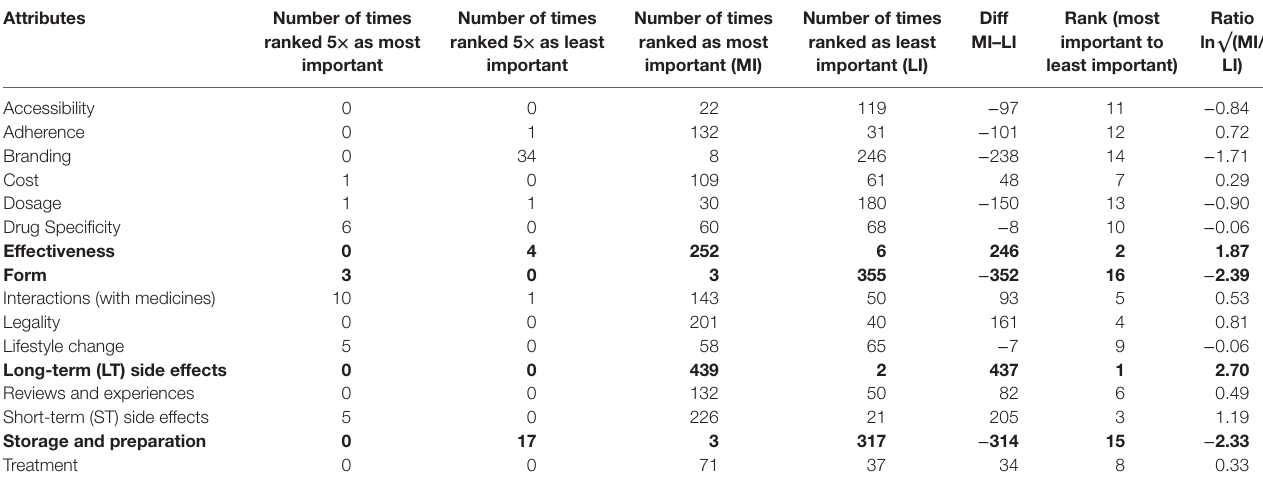
TaBle 3 | Attribute Best–Worst Scale counts, interval scale difference scores, and (pseudo-)ratio scale. attributes